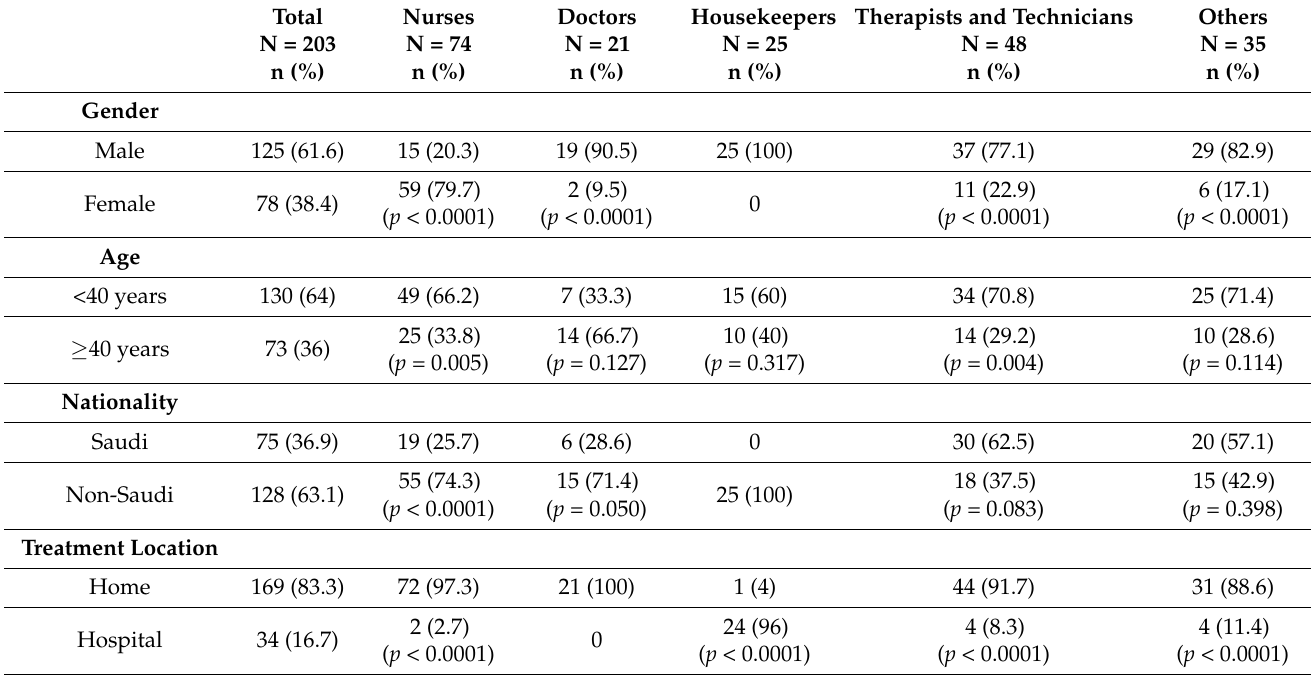
Figure 3. ( a ) Source of infection as determined by infection control contact tracing investigation, ( b ) treatment location of HCWs. Groups compared using the chi-squared (nonparametric) test, * p -values of <0.05 are considered statistically significant. Table 4. Gender, age, nationality, and treatment location comparisons among healthcare